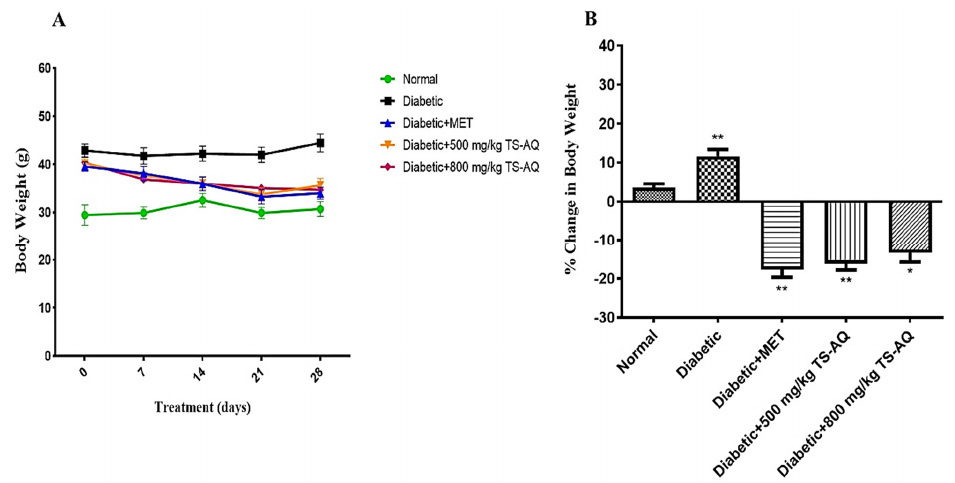
Figure 4. Effect of thyme extract on body weight. ( A ) Measurement of body weight after every 1 week of the treatment. ( B ) The % change in body weight of each group was calculated by the formula: (body weight on day 28 − , body weight on day 0)/body weight on day 0 × 100. * Depict statis- tical significance. * = p < 0.05. ** = p < 0.01. ( n = 10 for each group).